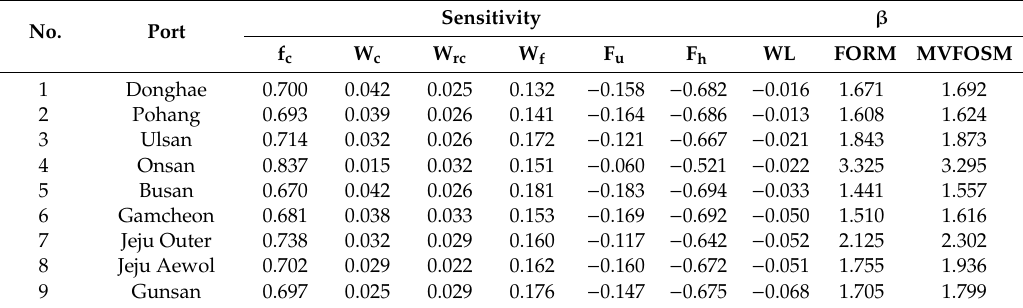
Table 4. Results of mean value first-order second-moment (MVFOSM) and first-order reliability method (FORM) for sliding failure